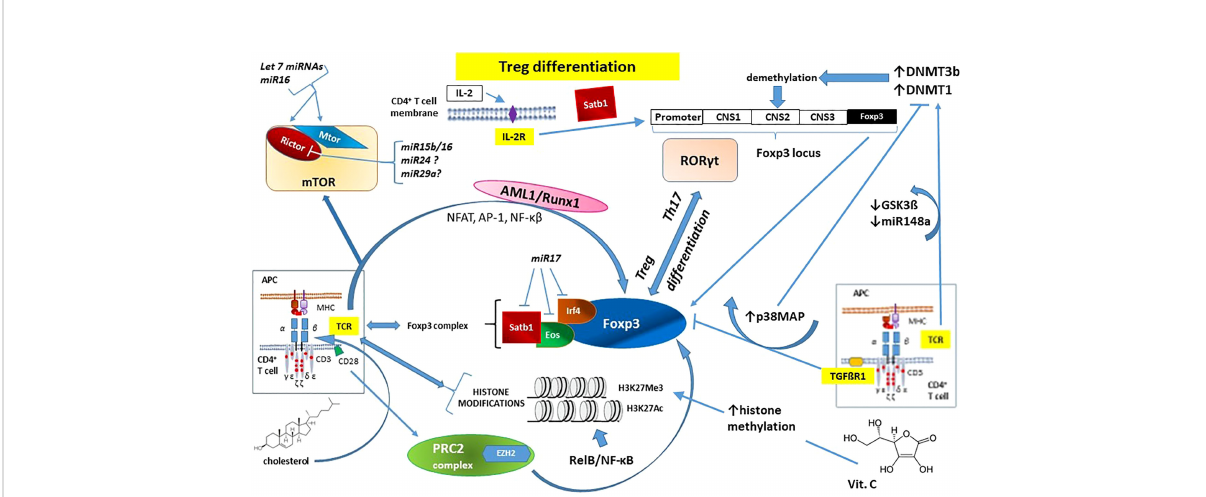
FIGURE 3 The essential role of epigenetic changes in regulatory T cell (Treg) development and function on the example of forkhead box P3 (Foxp3) - the master regulatory protein involved in Treg-mediated immune system responses. Noticeable that IL-2 action does not involve TCR signaling pathway. See the main text (Chapter 2.2.1. Epigenetic mechanisms in fl uencing TCR signaling and autoimmunity) for details. AML1/Runx1 – Acute myeloid leukemia 1 protein or Runt-related transcription factor 1; AP-1 – activator protein 1; CD – cluster of differentiation (cell surface marker); CNS1-3 – conserved non-coding sequences; APC – antigen-presenting cells; DNMT – DNA methyl-transferase; Eos – transcription factor, member of the Ikaros Zinc Finger (IkZF) family of transcription factors; EZH2 – Enhancer of Zeste Homolog 2; Foxp3 – forkhead box P3